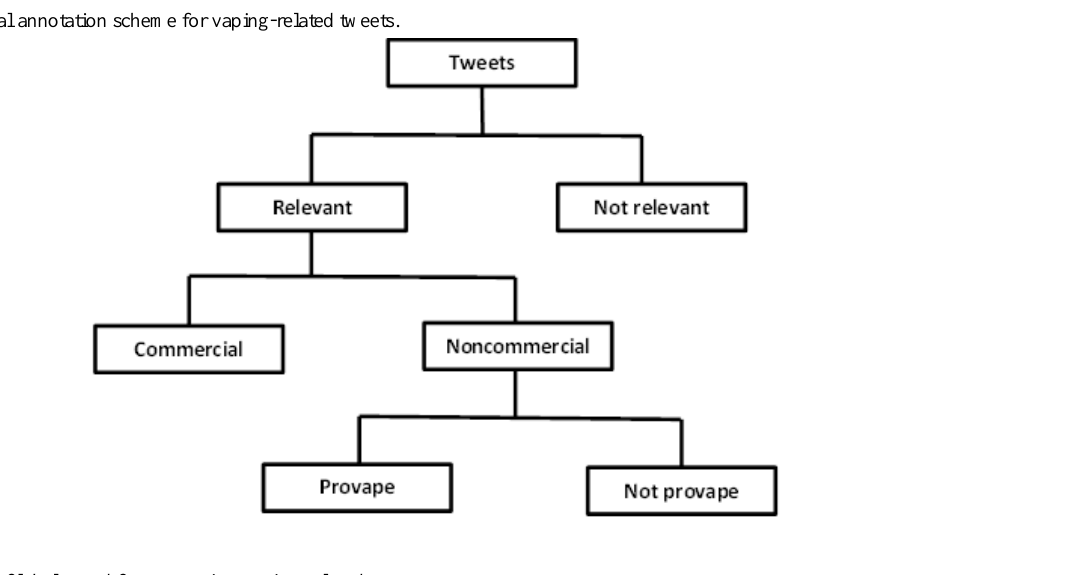
Figure 1. A hierarchical annotation scheme for vaping-related tweets.